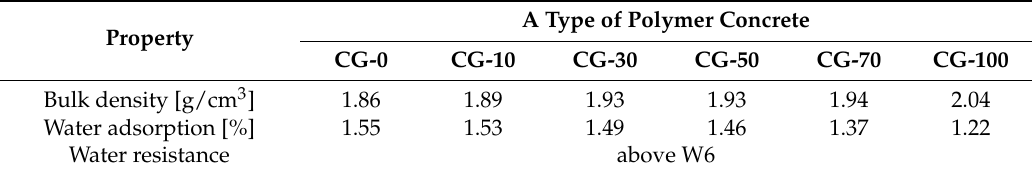
Table 5. Physical Properties of the Polymer Concrete with